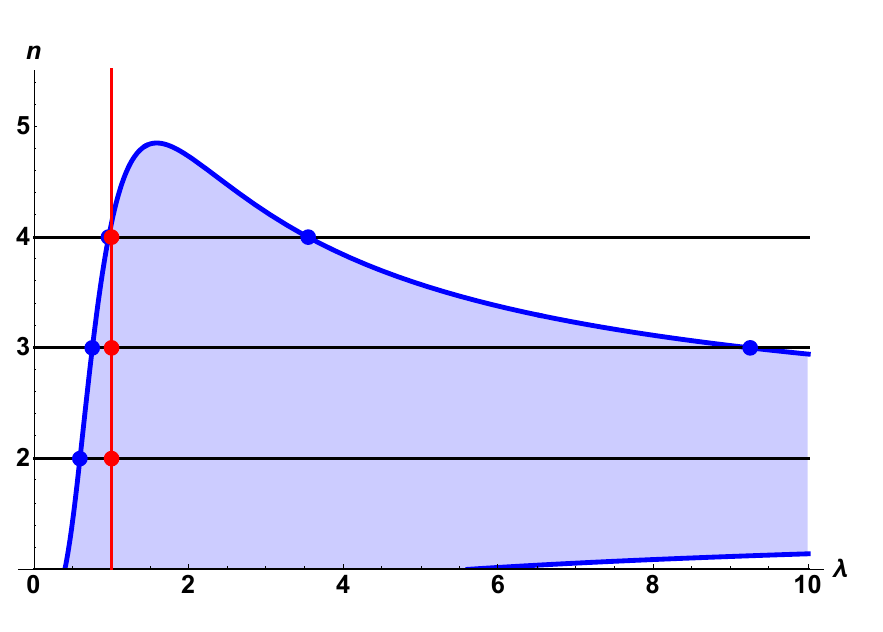
Figure 2 . Domain of asymptotically free gauge theories (shadow blue area). Horizontal lines correspond to local theories and λ is the extra parameter of the generalized Laplacian operator (3.8). Red points mark theories with Hodge Laplacians ( λ = 1 ) and blue points UV-finite theories. In the limit λ → ∞ the upper and lower curves converge at n = 2